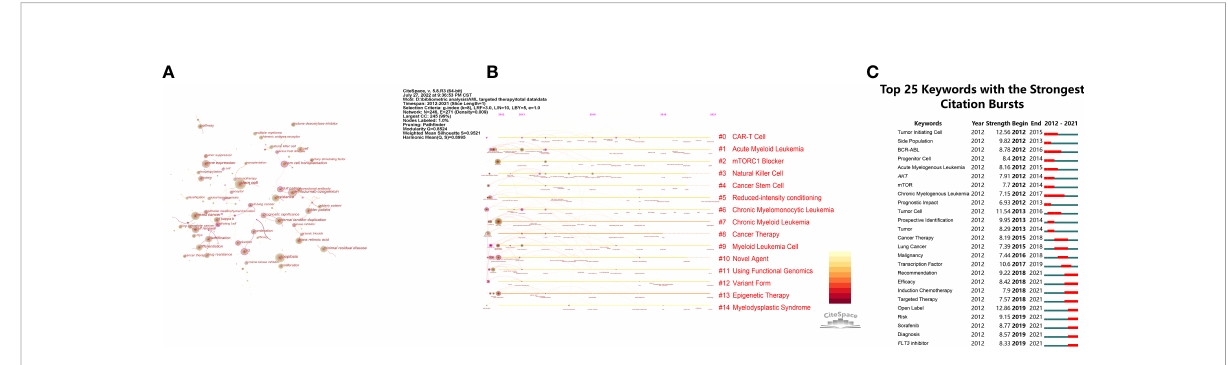
FIGURE 4 Co-occurrence and clustering of keywords. (A) Network of main keywords in publications. The circle in (A) indicates the keyword; the larger the size of the circle, the higher the frequency of the keyword. Purple circles represent the node of BC > 0.1: purple circles are thicker and the BC is higher. (B) Timeline view of keywords. Each horizontal line represents a cluster; the circular nodes on the line represent the top three keywords with the highest frequency of occurrence in this time slice. The timeline is shown at the top of the fi gure, and the year corresponding to the node is its publication time. The link between nodes represents the co-citation relationship. (C) The 25 keywords with the strongest citation bursts. The blue line denotes the time axis, whereas the red segment on the blue time axis shows the burst detection, indicating the start year, end year, and burst